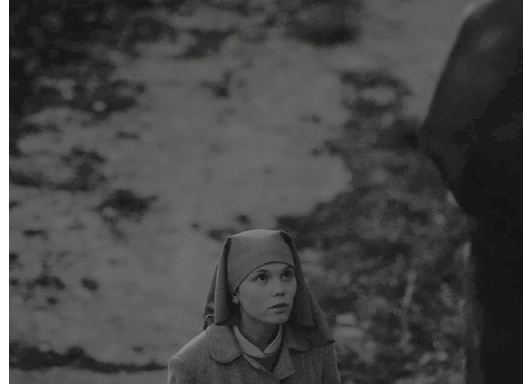
Figure 5. The darkened statue. Figure 6. Ida prays, “Forgive